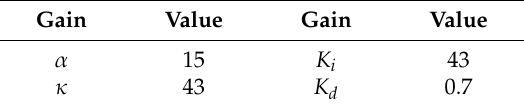
Table 1. 2nd-SMC feedback gains.